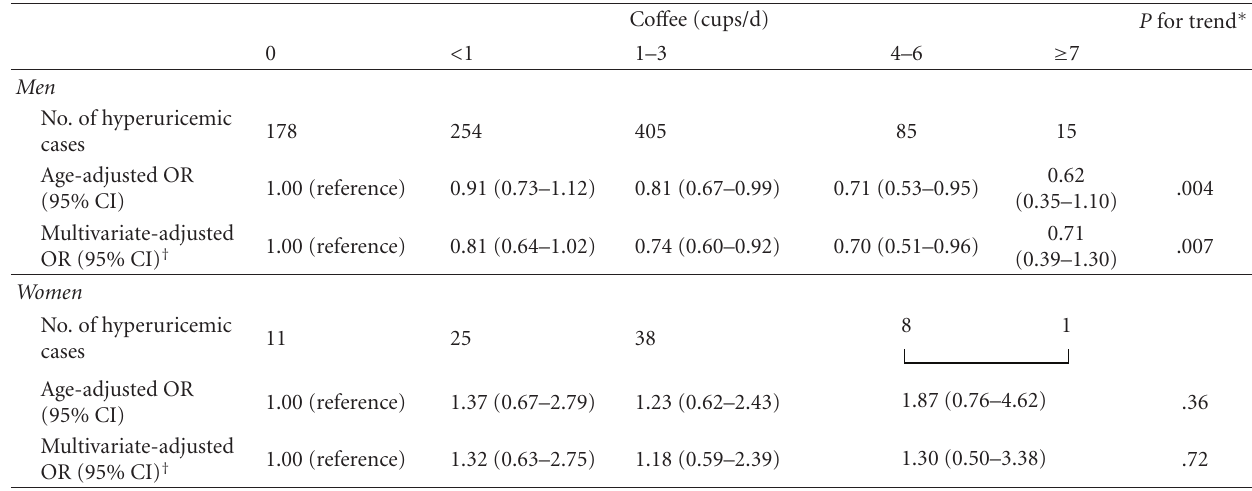
Table 4: Age-adjusted and multivariate-adjusted odds ratios (95% CI) of hyperuricemia according to co ff ee consumption in men and